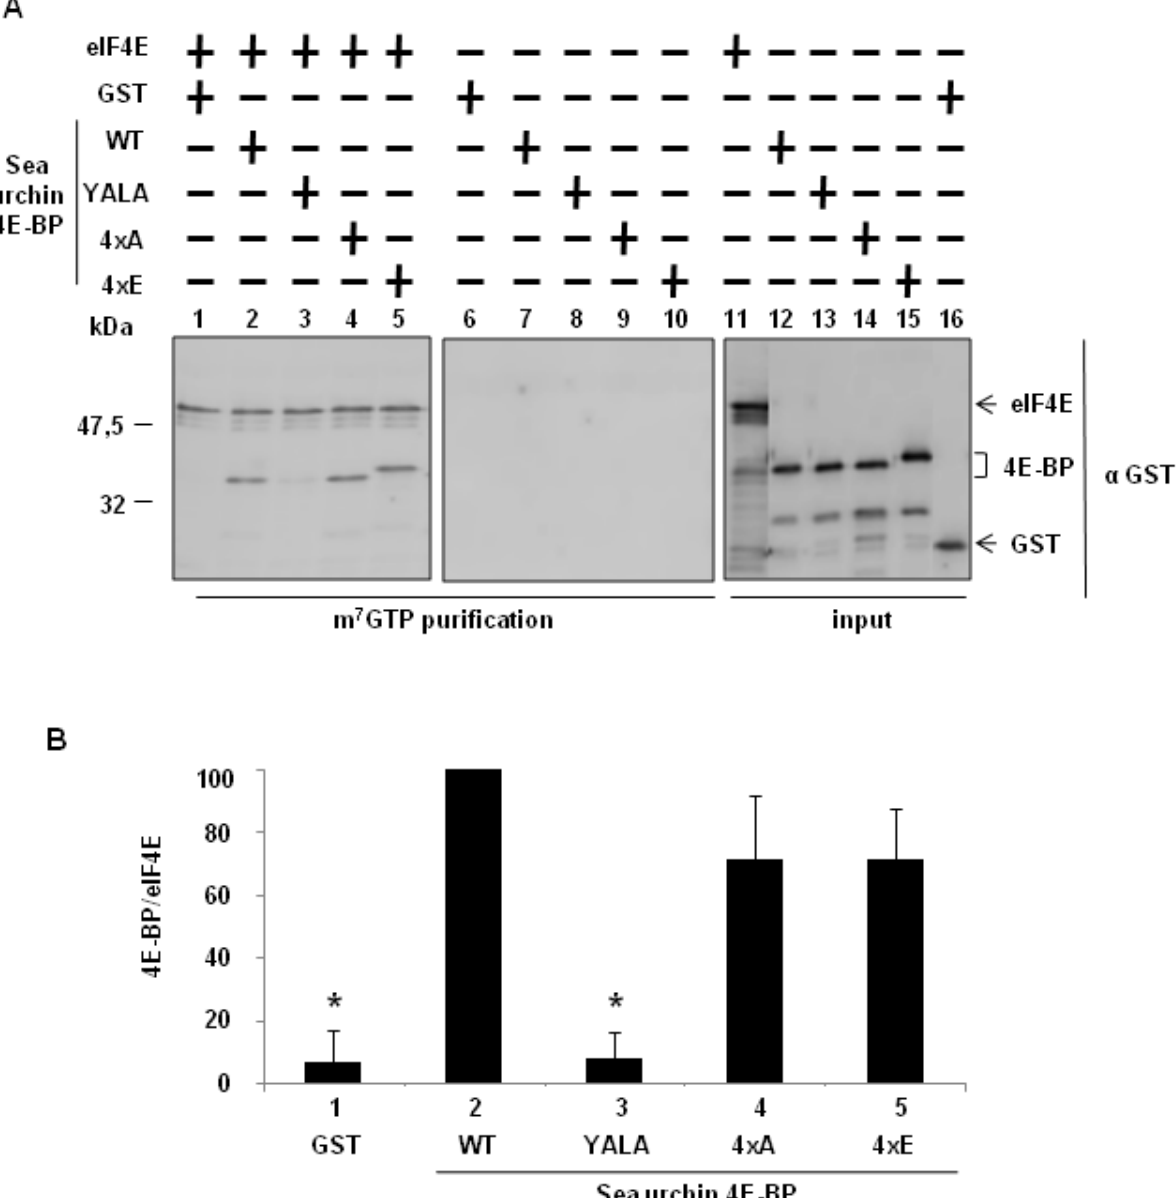
Figure 6. The variant mimicking hyperphosphorylation of Sg4E-BP also binds to eIF4E. (A) The S/T-E Sg4E-BP mutated at all four phosphorylation sites (4xE) binds to eIF4E. GST-mIF4E (eIF4E) was incubated with m 7 GTP sepharose beads (lanes 1–5) and the GST recombinant proteins were added: GST, GST-Sg4E-BP WT (WT), GST-Sg4E-BP YALA (YALA), GST-Sg4E-BP 4xA (4xA), GST-Sg4E-BP 4xE (4xE). Complexes were affinity purified and analysed by Western blot using a GST antibody. Lanes 6–10, GST-mIF4E was omitted as control for binding specificity. Inputs are shown on the right panel (lanes 11–16). They represent 10% of the volume used in the experiment. (B) Binding between the GST recombinant proteins and GST-mIF4E was analysed by quantification of the signals obtained on the Fig 6.A, using Image Quant software. Error bars represent the standard deviation (s.d.) of two experiments. Significance was assessed using Fisher’s F -test and Student’s t -test. * P , 0.01 significant difference between GST or GST-Sg4E-BP YALA with GST-Sg4E-BP